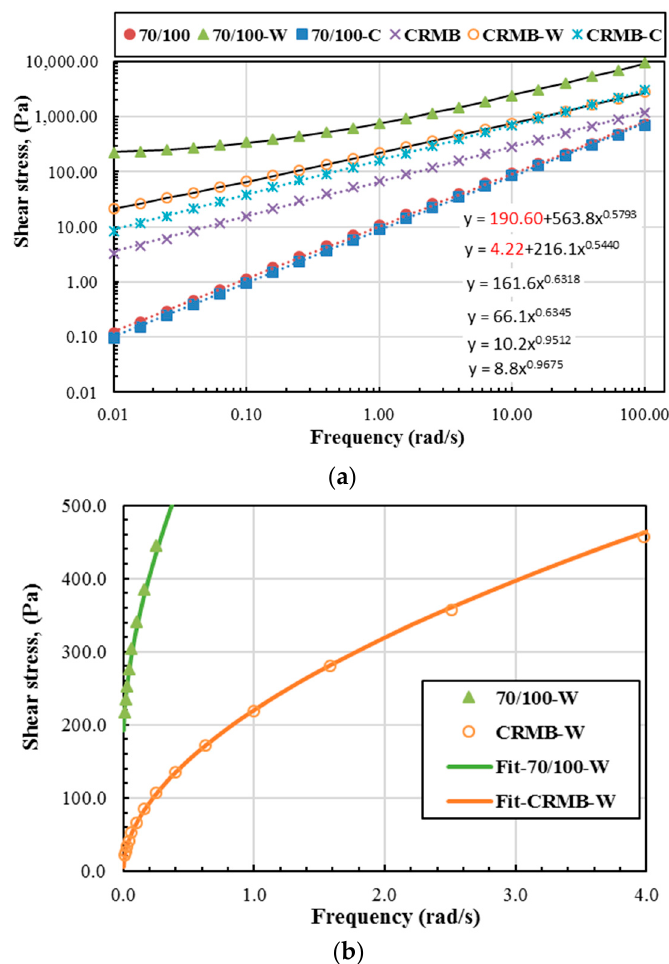
Figure 6. Yield stress calculation of different binders at 50 °C ( a ) entire curve; ( b ) partial curve.